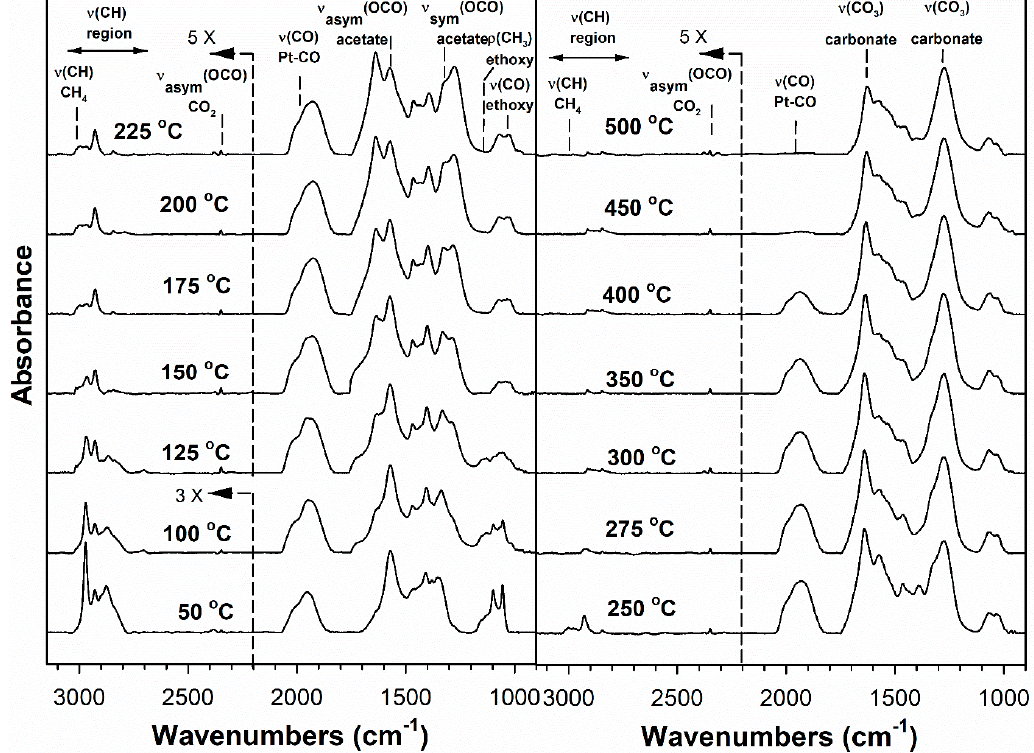
Figure 7. DRIFTS of transient ethanol steam reforming over 4.8% Cs-2% Pt/ZrO 2 .